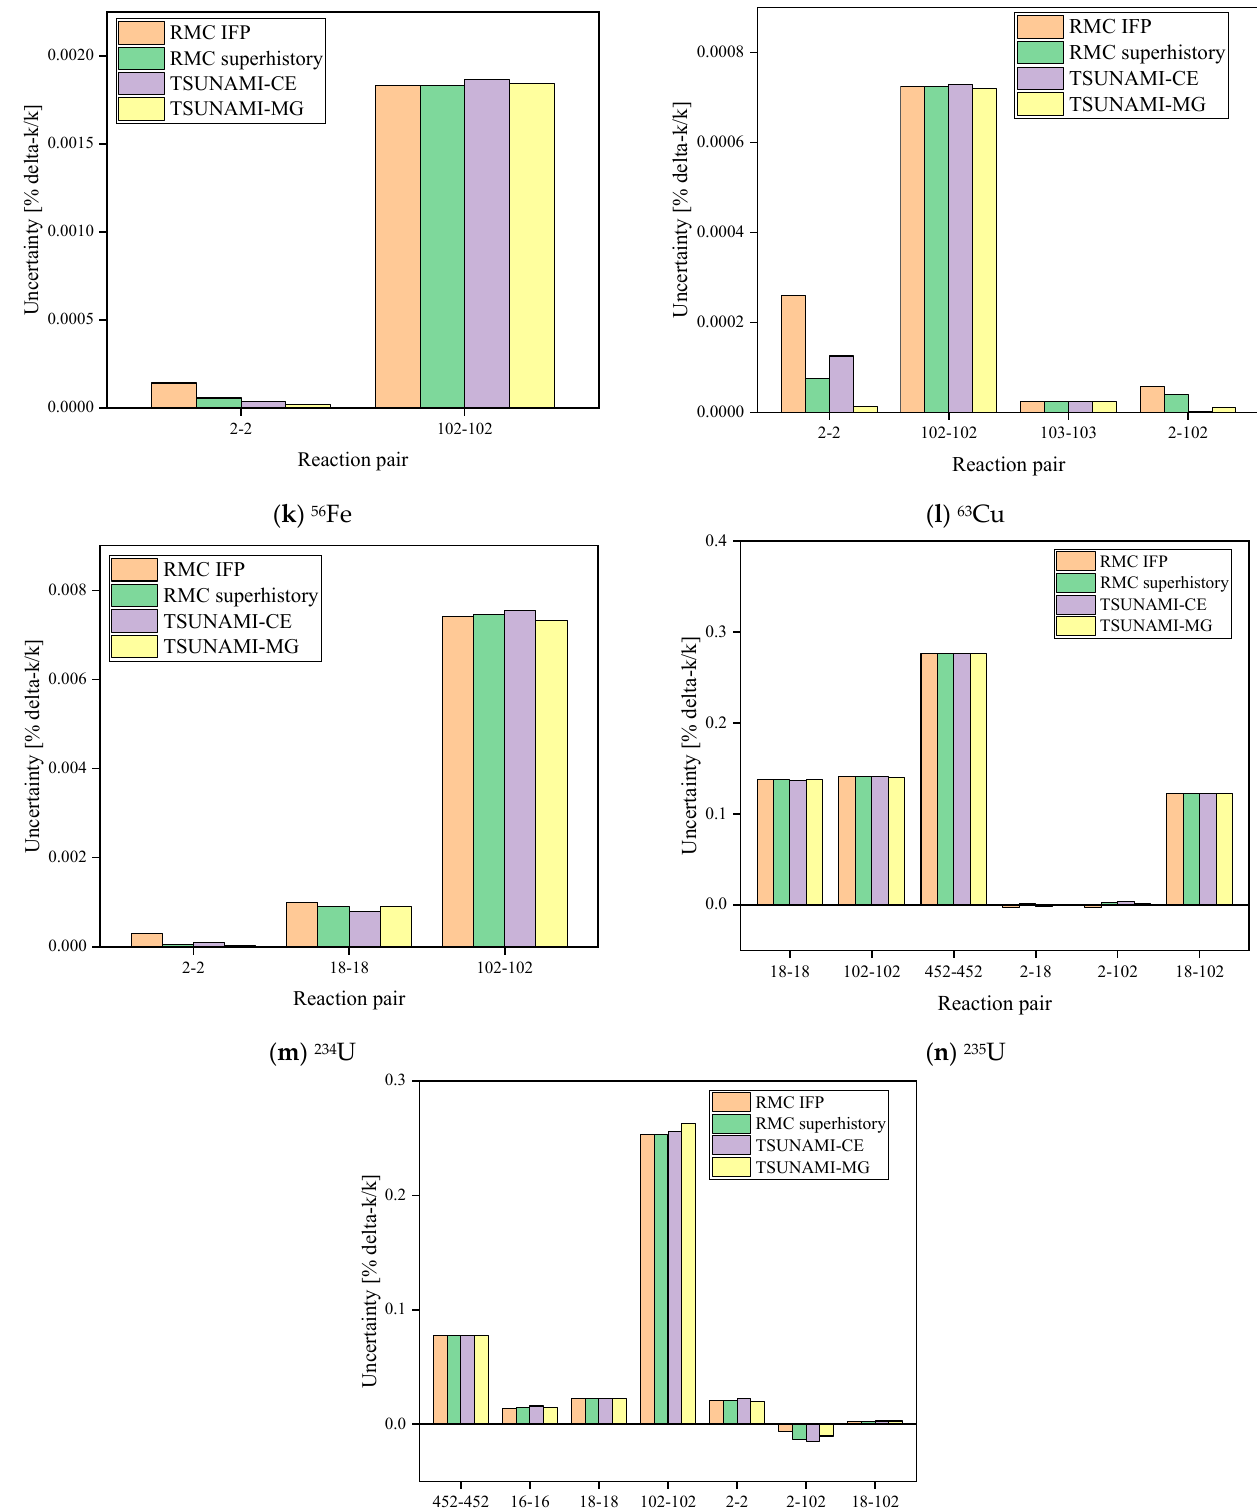
Figure 7. Uncertainty of partial reaction pairs of different nuclides.